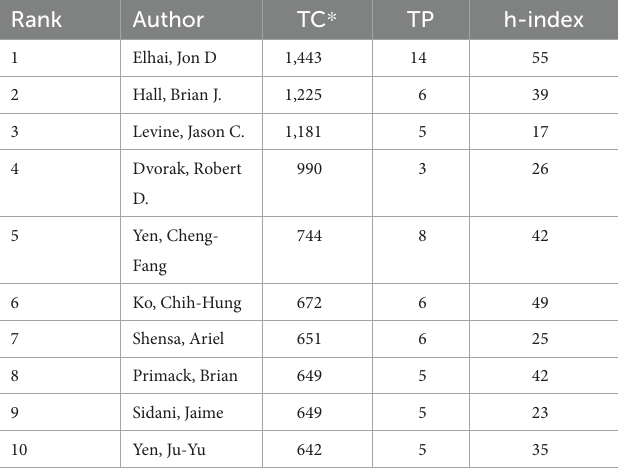
TABLE 2 Top 10 authors most cited in the digital addiction–depression research